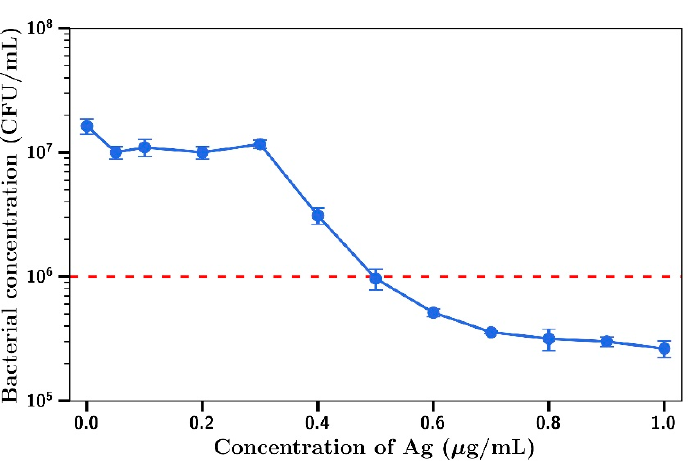
Figure 3. S. aureus concentration at t = 4 h with 0.25 µg/mL gentamicin and varying Ag concentra- tions ( n = 3).